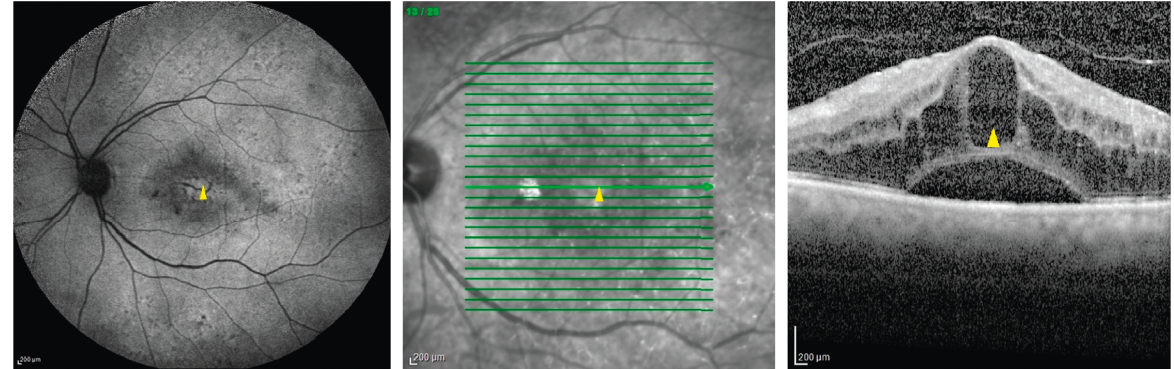
Figure 2: Autofluorescence (left image) and near-infrared reflectance (middle image) taken with OCT SLO image with related OCT image (right image) show hyperautofluorescence and hyperreflectivity at the site of large cyst (yellow arrowhead) and hypoautofluorescence and hyporeflectivity around it concordance with subretinal